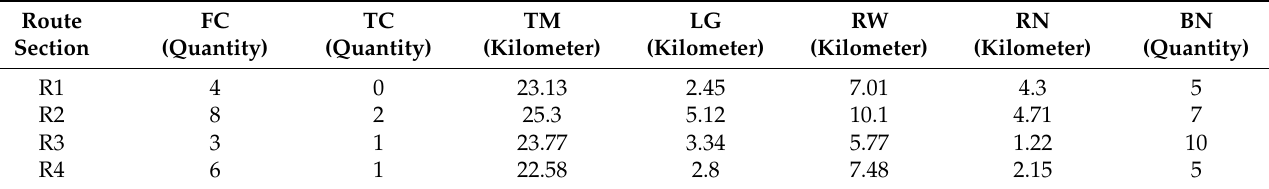
Table 1. Alternative routes attribute